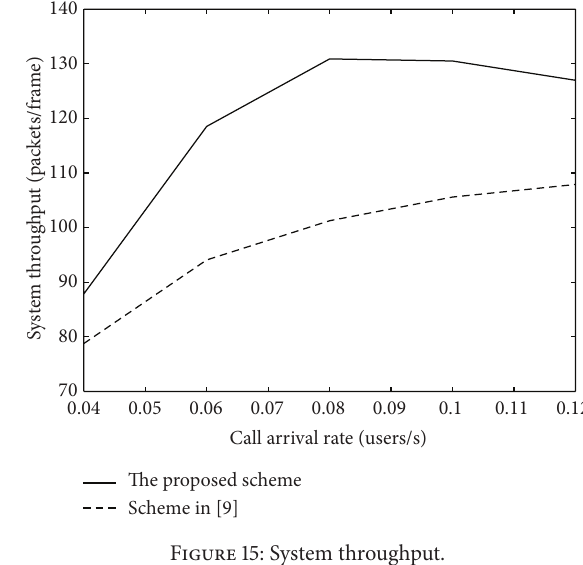
Figure 15: System